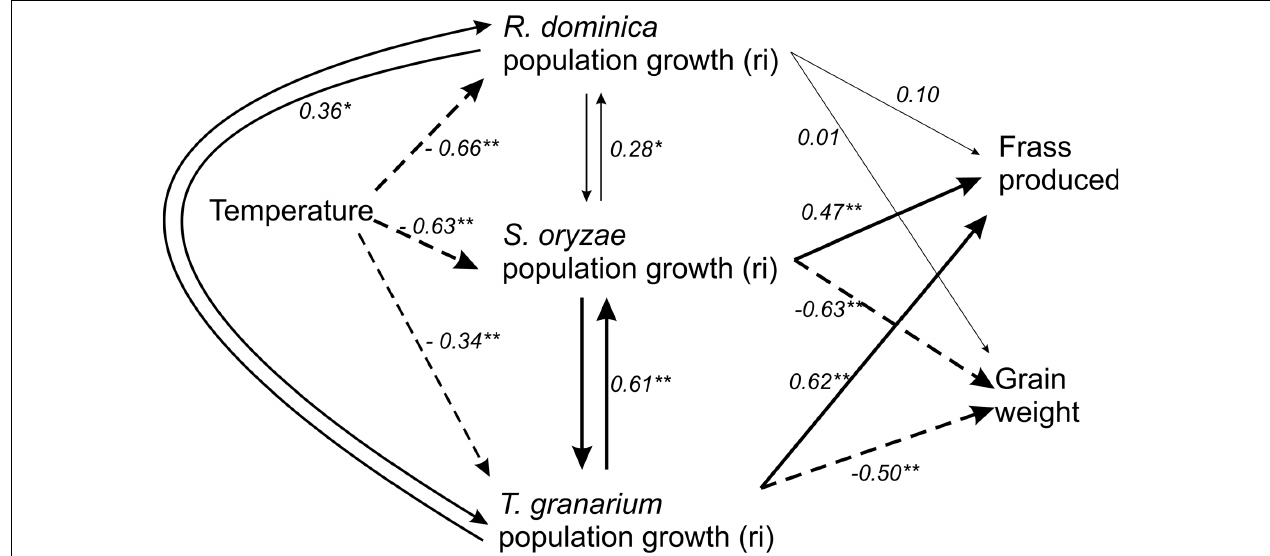
FIGURE 9 | Path analysis diagram for the influence of temperature and interspecific competition on the population growth of three stored-grain insects ( R. dominica , S. oryzae, and T. granarium ), the frass and grain loss generated. One-headed arrows indicate causal relationships (regression), while double-headed arrows indicate correlation between variables. Significance levels are represented by asterisks ( ∗ P < 0.05; ∗∗ P < 0.01), and the thickness of each line is proportional to the strength of the relationship. Solid arrows indicate positive relationships, while dashed arrow lines indicate negative relationships. Direct, indirect, and total values for path coefficients are fully presented in Table 1